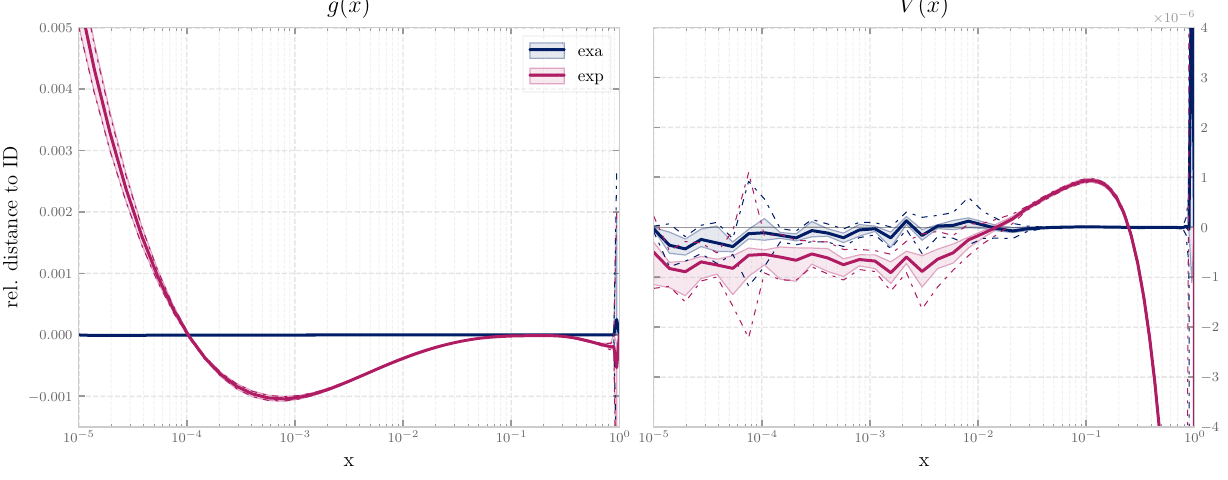
= 4 . 90 2 GeV 2 , 4 . 92 2 GeV 2 . In particular the lower scale is chosen μ 2 F = 4 . 94 2 GeV 2 while the upper is equal to μ 2 F = b